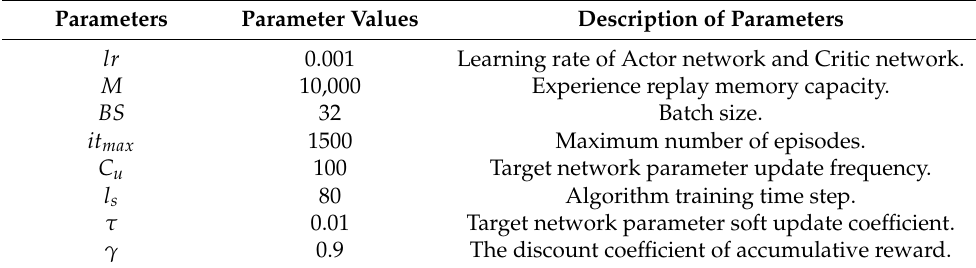
Table 7. Detailed description of the parameters of the CDA algorithm. Parameters Parameter Values Description of Parameters lr 0.001 Learning rate of Actor network and Critic network. 10,000 Experience replay memory capacity. 32 Batch size. 1500 Maximum number of episodes. 100 Target network parameter update frequency. 80 Algorithm training time step. 0.01 Target network parameter soft update coefficient. 0.9 The discount coefficient of accumulative